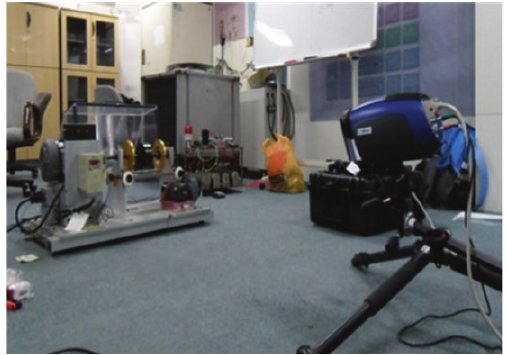
Figure 3: Data acquisition process.